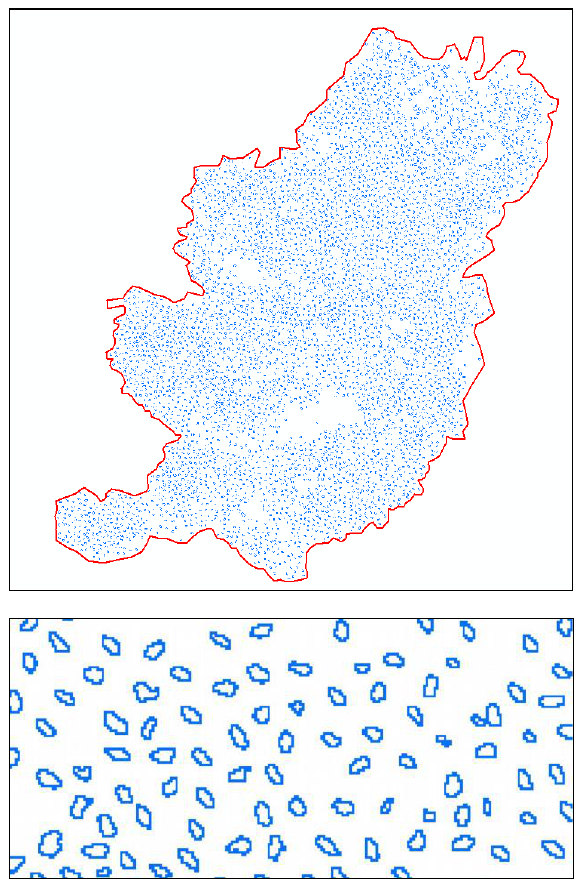
Figure 7. The polygon of the selected penguin group and result of automatic estimation of the objects.